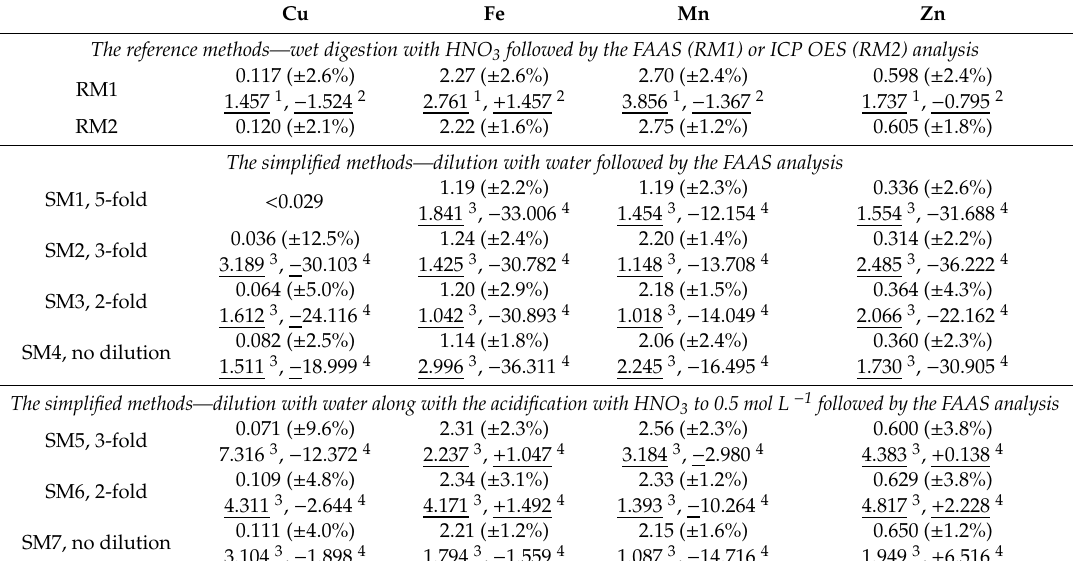
Table 1. Comparison of the total concentrations of Cu, Fe, Mn, and Zn (in mg L − 1 ) determined in